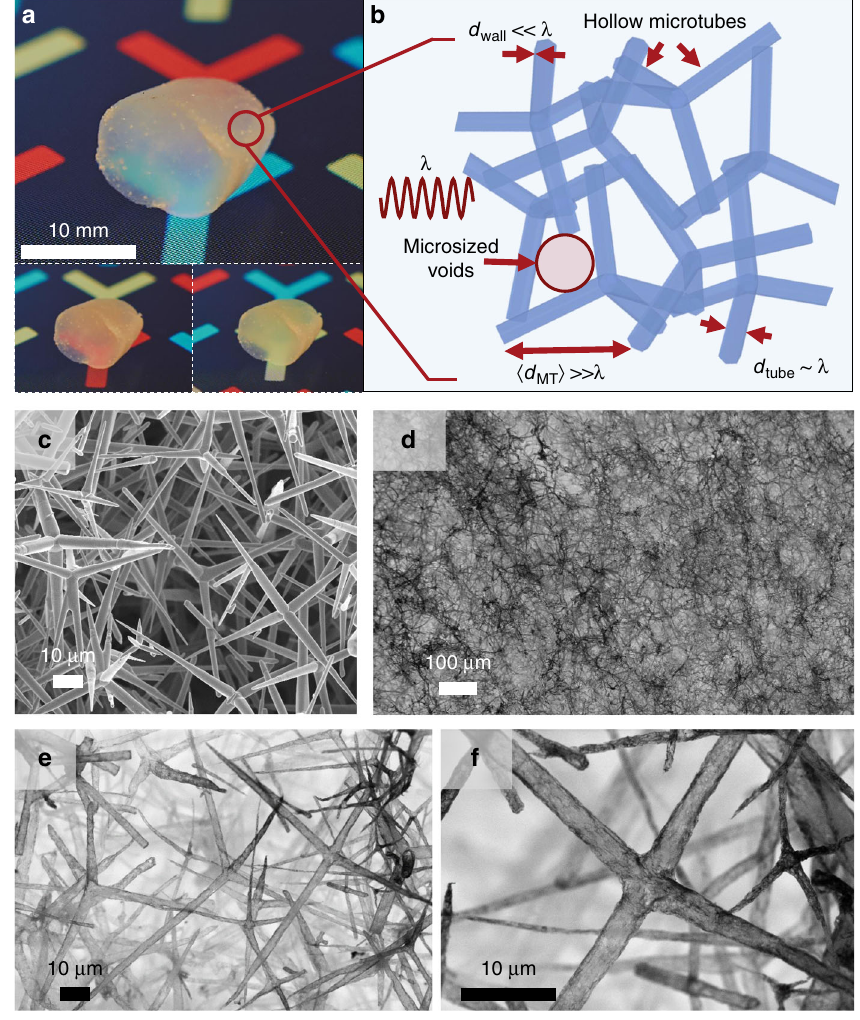
Fig. 2 Arti fi cial solid fog. a Photographs of Aero-BN. A thin (< 25 nm) hBN layer is grown by CVD using macroscopically expanded templates of tetrapodal ZnO microparticles. The hBN layer encloses the entire template structure, while it is simultaneously removed by hydrogen etching, resulting in a free-standing, low density (< 1 mg cm − 3 ) network, consisting of interconnected hollow hBN microtubes. b The structure resembles an arti fi cial solid fog, i.e., a highly optically disordered (completely randomised) photonic system with a combination of feature sizes greater than, equal to, or well below the impinging light wavelength. c Representative scanning electron microscopy (SEM) micrographs of the ZnO template consisting of interconnected microrods. d – f SEM micrographs of the resulting Aero-BN after CVD. The microtubes have an average length ~25 μ m, diameter between 300 and 3000 nm, and < 25 nm wall Fig. 2d – f. Thus, d tube is of the same order of magnitude as the transformation of the ZnO microrod structure in which a thin wavelength of visible light. The hBN CVD process results in wall- thicknesses d wall < 25 nm. This is much smaller than the wave- length of visible light, promoting light-matter interactions that are dominated by Rayleigh-type scattering 25 . As for Fig. 2f, the hBN microtube walls consist of randomly arranged, interconnected hBN nanoplates (see also Supplementary Fig. 6). The average network is shown in Fig. 2a. Calculations indicate that the speci fi c distance between the individual microtubes, d MT , is several μ m, surface area of the hBN foams is in the order of 900 m 2 g − 1 (see Supplementary Note 3). Energy dispersive X-ray spectroscopy larger than the visible light wavelength. The resulting Aero-BN (EDX, Supplementary Fig. 5) show that the ZnO template is network architecture leads thus to an optical system with micro- completely removed during CVD. The process results in a dis- scopic (optical) density fl uctuations (volumes fi lled with air and ordered 24 macroscopic network, Fig. 2b, consisting of inter- with hBN microtubes) throughout the macroscopic structure, as indicated in Fig. 2b. The CVD process is similar to that used to connected hollow hBN microtubes, with individual features prepare macroscopically expanded nano architectures based on varying in well-de fi ned sizes and dimensions. The as-synthesized interconnected ZnO microrod networks 26 – 28 , with the main dif- hollow hBN microtubes have an average length ~25 µm, and their ference that the hBN is grown here by using the sacri fi cial ceramic diameter, d tube , is between 300 and 3000 nm, depending on the geometry of the used ZnO microrods (Fig. 2c) as shown in template.